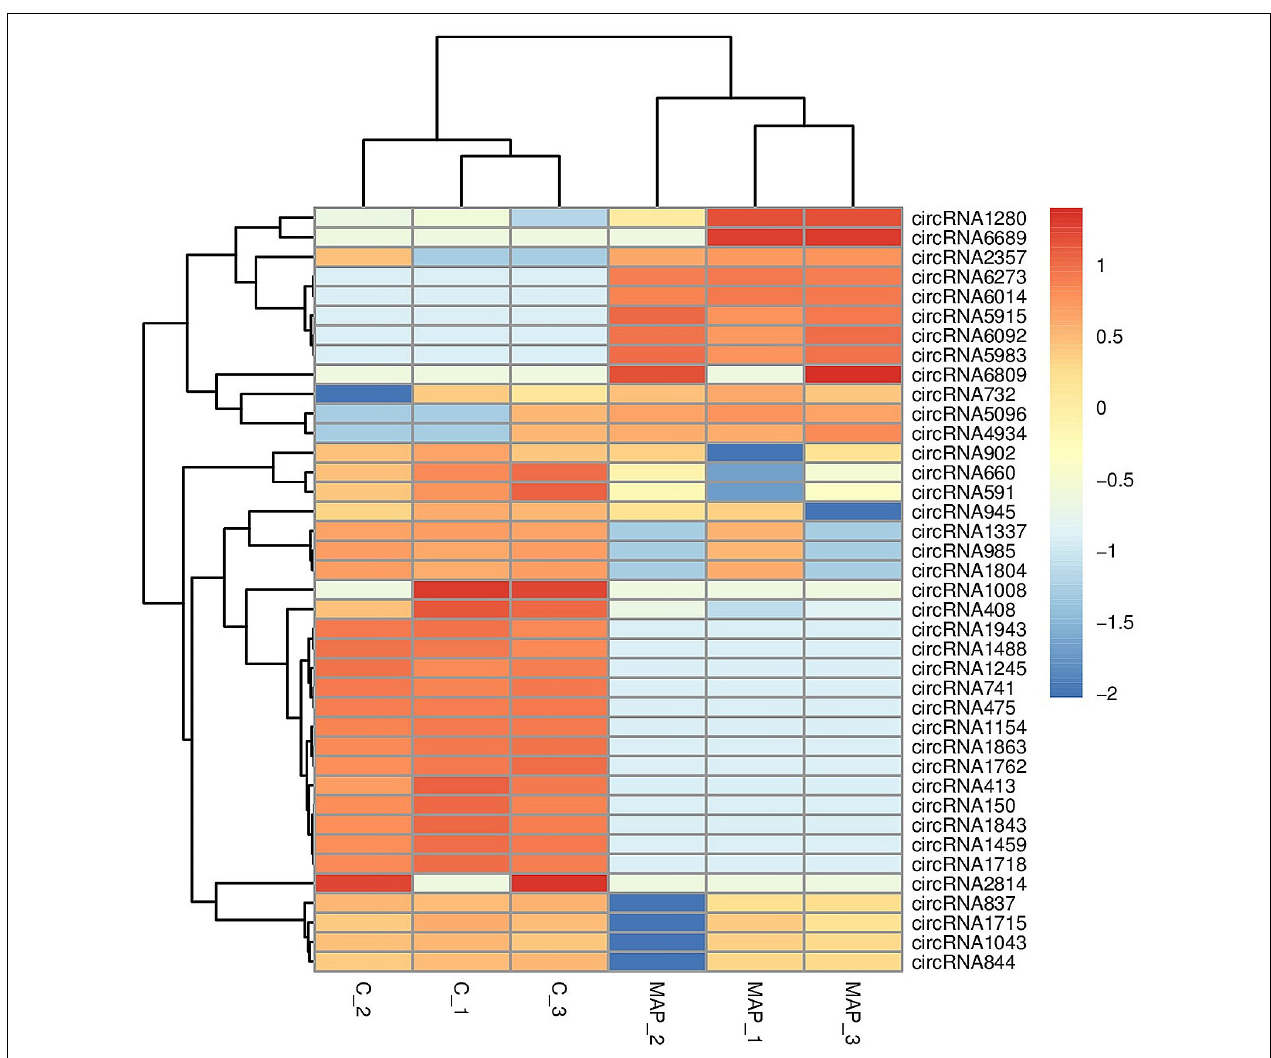
FIGURE 10 | Cluster analysis of differentially expressed circRNA. The abscissa is the sample, and the ordinate is the differentially expressed genes screened out. Red indicates highly expressed genes, and dark blue indicates low expressed